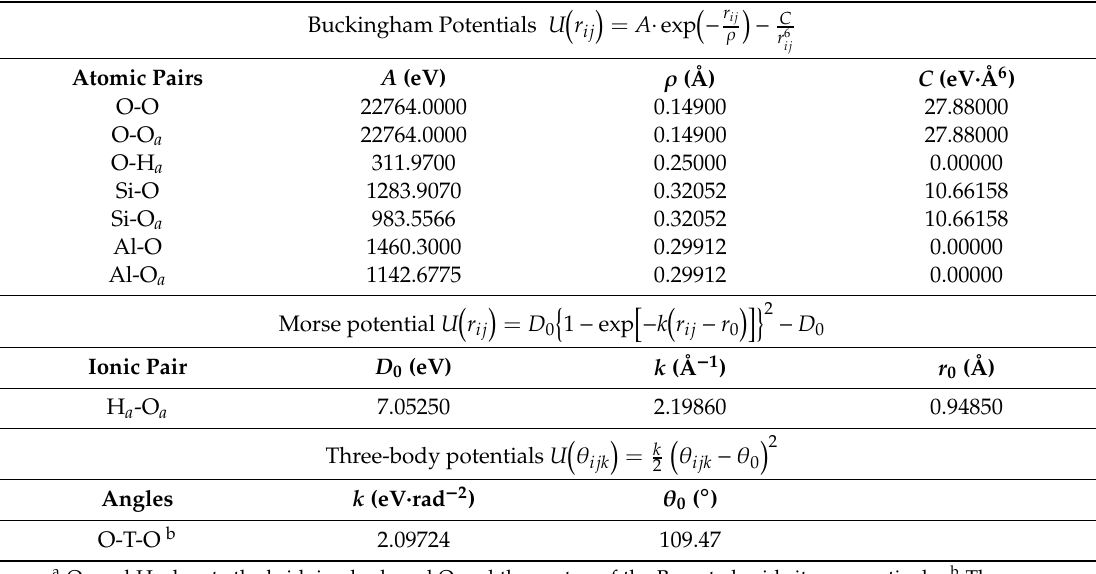
Table 4. Potentials describing the interatomic interactions within the zeolite framework and the Brønsted acid sites a .